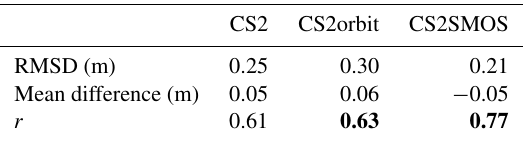
Table 4. Statistics for the comparison between gridded CS2, CS2orbit and gridded CS2SMOS mean sea ice draft with modal Taymyr and 1893 ULS sea ice draft from the 2013/2014 and 2014/2015 periods. Due to the low temporal resolution of the ADCP-derived VAL data, modal sea ice draft was only calculated for ULS data. RMSD and mean difference were calculated for the difference between mean satellite minus modal VAL data. The Pear- son correlation coefficient, r , was calculated for each of the four VAL data sets. The values show the mean of RMSD, mean differ- ence and r over the four VAL data sets. Bold mean correlation co- efficients indicate significance of all four correlation coefficients at the 95% confidence level. None of the correlations were significant for the CS2 data.